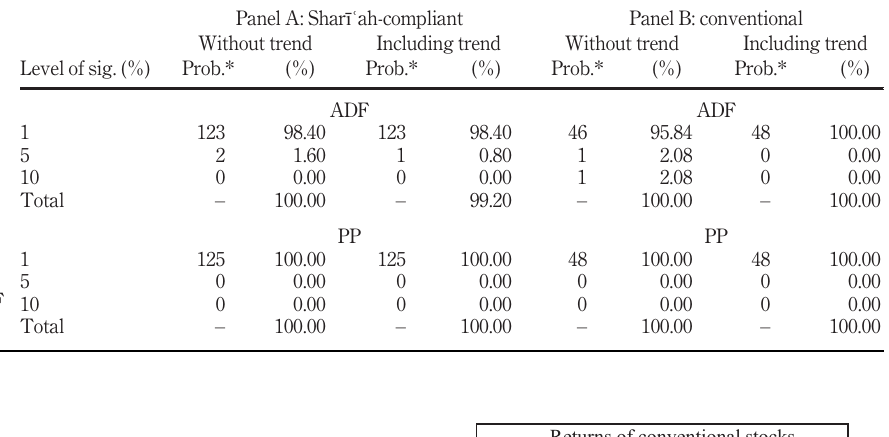
Panel A: Shar ī ʿ ah-compliant Panel B: conventional Without trend Including trend Without trend Including trend Level of sig. (%)